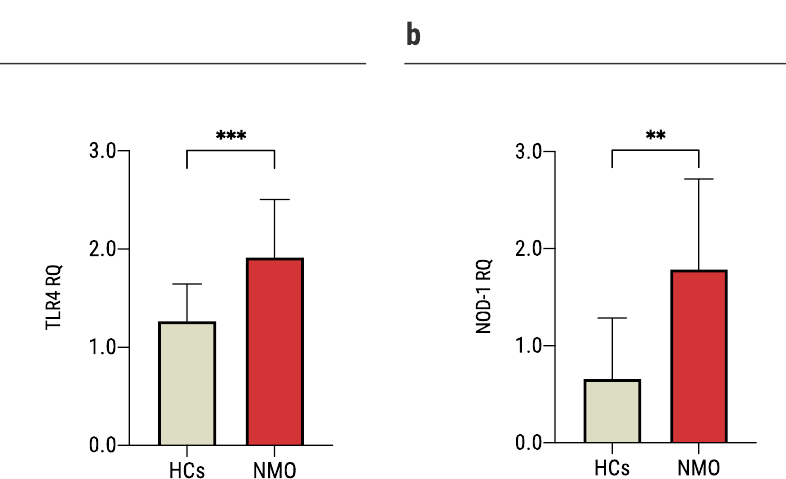
Figure 6. Increased pro-inflammatory gene expression upon exposure of astrocytes to sera of NMO patients. Quantitative PCR gene expression analysis of: ( a ) the expression of TLR4 increased significantly in astrocytes cultured with sera of NMO patients (1.9 ± 0.6, n = 19) vs. 1.26 ± 0.4 ( n = 19) of astrocytes cultured with sera of HCs, ( b ) the expression of NOD-1 increased significantly in astrocytes cultured with sera of NMO patients (1.8 ± 0.9, n = 15) vs. 0.66 ± 0.62 ( n = 11) of astrocytes cultured with sera of HCs. Each assay was repeated independently at least three times. Significance was determined by unpaired two-tailed student’s t -test ( p ** ≤ 0.01, *** ≤ 0.001). Error bars in all graphs represent standard deviation.